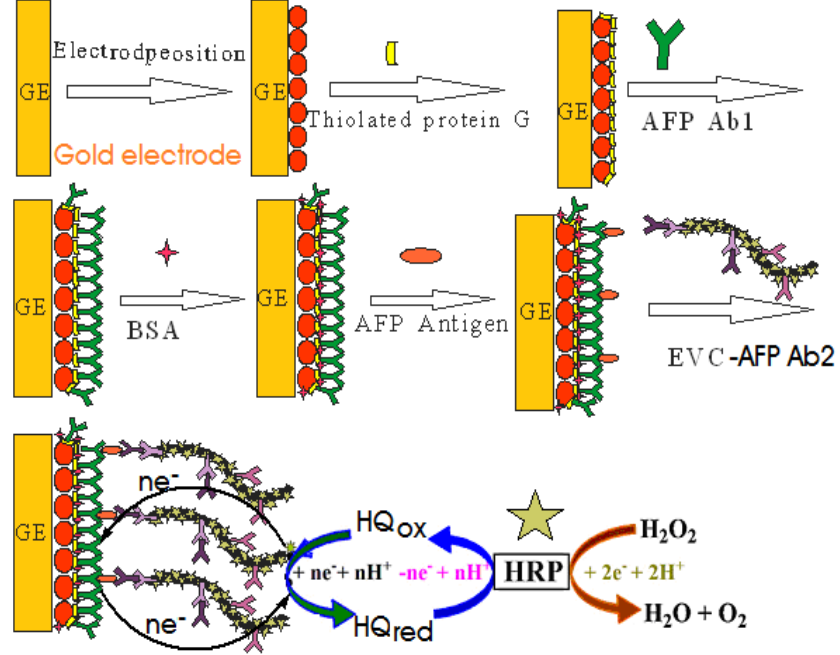
Figure 9. Schematic illustration of the fabrication and detection procedure of the